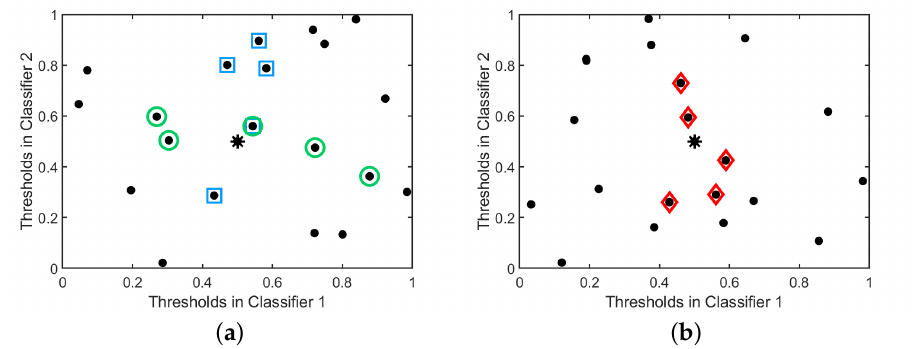
Figure 11. An illustration of the R-LA and R-EU strategies for the case with two classifiers. The star denotes the test sample and we set N = 5. ( a ) R-LA forms two sets of nearest neighbours: one based on d 1 (for Classifier 1, denoted by squares) and the other based on d 2 (for Classifier 2, denoted by circles). The classifier yielding the largest number of correctly classified samples from the corresponding set, is selected. ( b ) R-EU defines one common set of nearest neighbours for both classifiers (based on d eu , denoted by diamonds). The classifier that correctly classifies the largest number of samples in this common set is now selected. ( a ) R-LA strategy; ( b ) R-EU